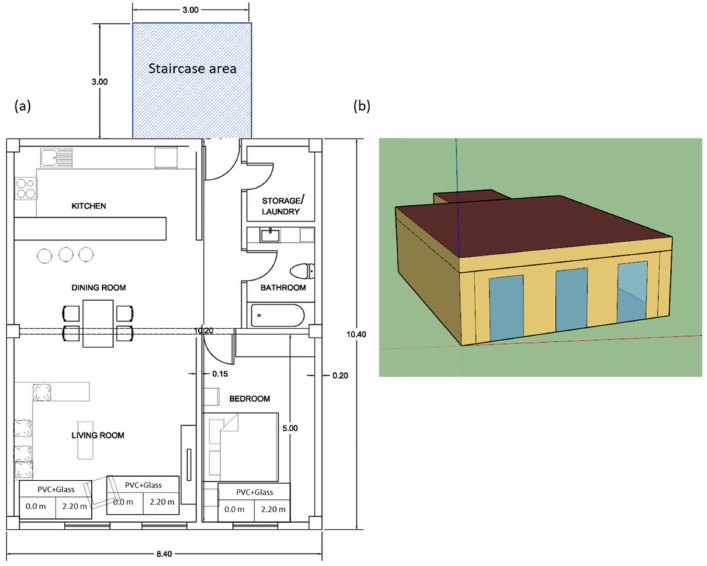
Figure 6. Plan of the typical building unit ( a ) and the corresponding 3D model ( b